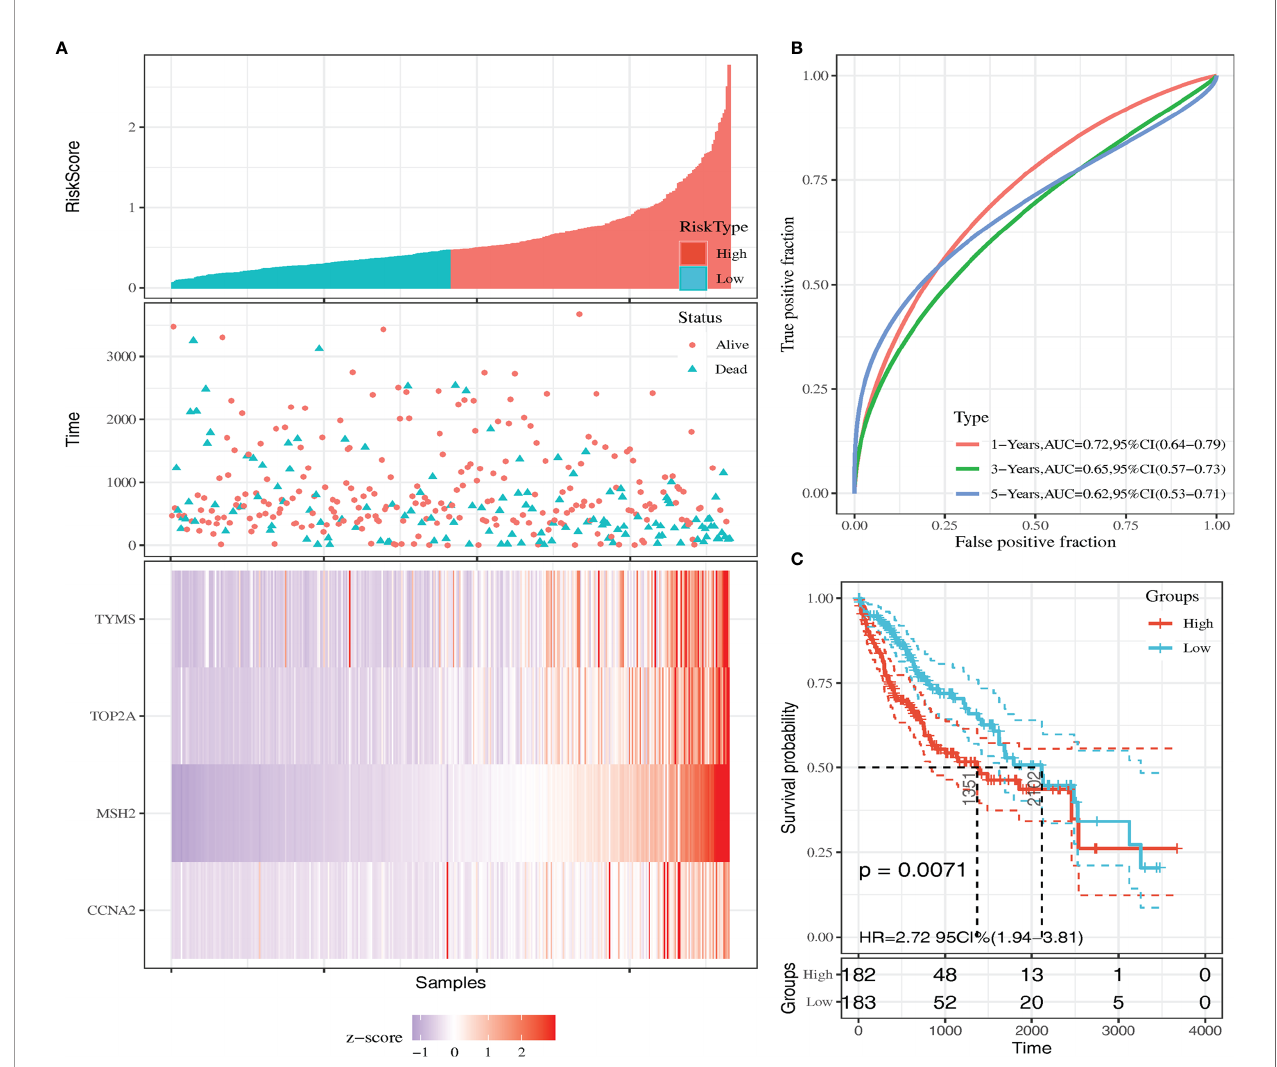
FIGURE 4 | Kaplan-Meier survival curve of overall survival between the high ‐ risk group and low ‐ risk group (A) Risk score, survival time, survival status, and expression of the four genes signature. (B) AUC for the four genes classi fi cation. (C) Kaplan-Meier survival curve of the four genes from the TCGA